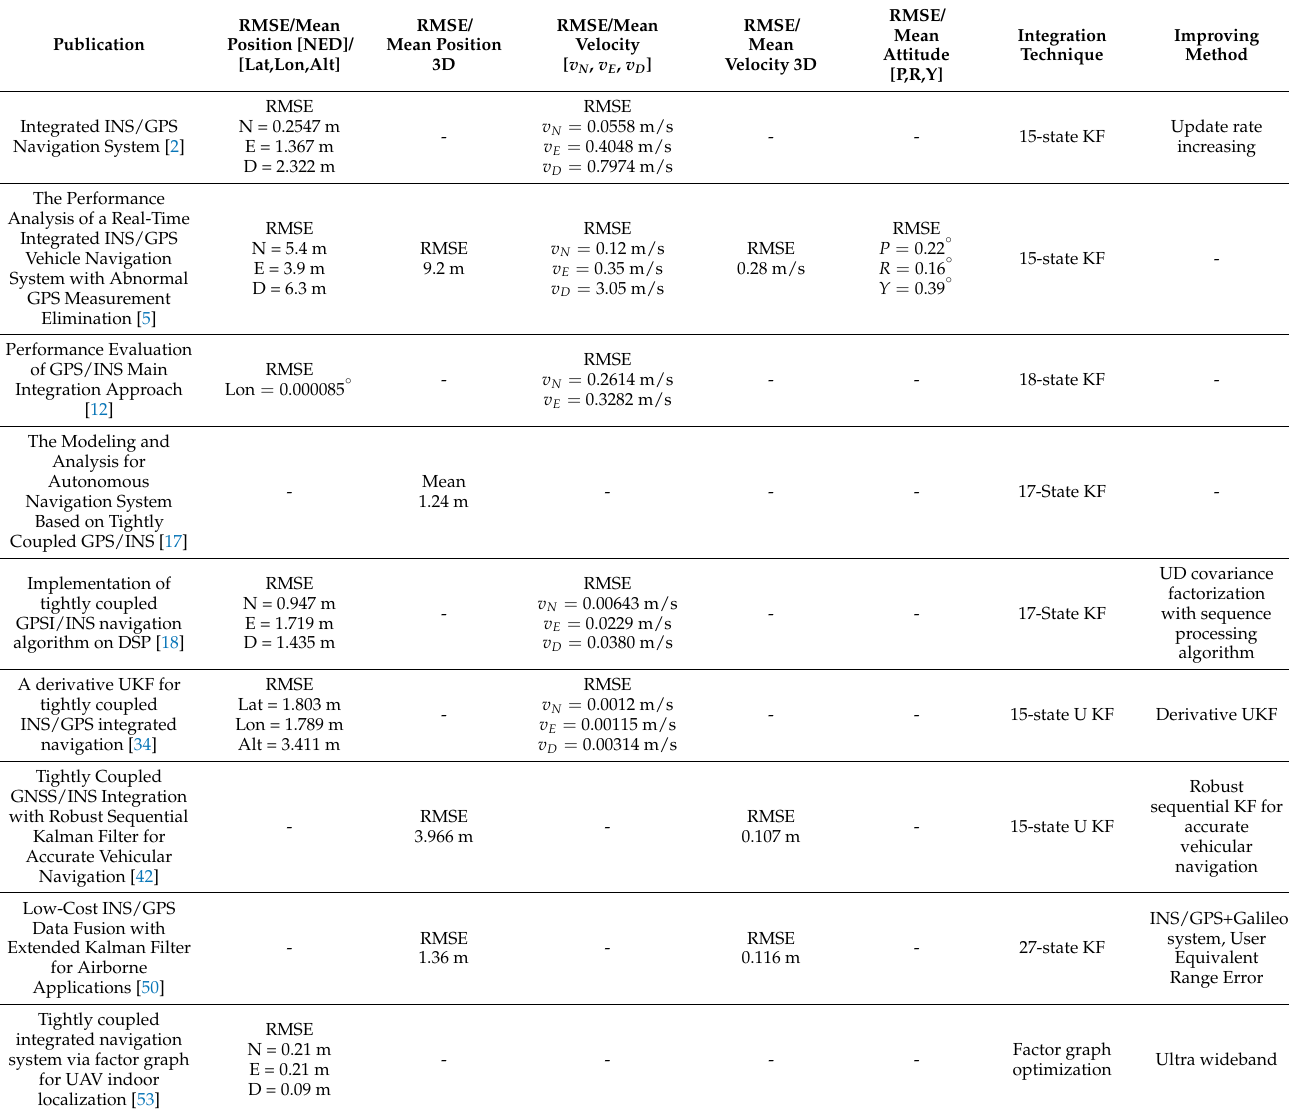
Table 2. Comparative characteristics of tightly coupled integrated GNSS/INS systems in terms of mean error or RMSE and methods used to improve the operation of integrated INS/SNS